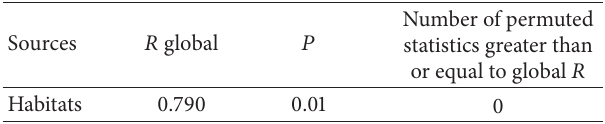
Table 1: Results of analysis of similarity ANOSIM of phytoplankton abundances in water column according to habitat.